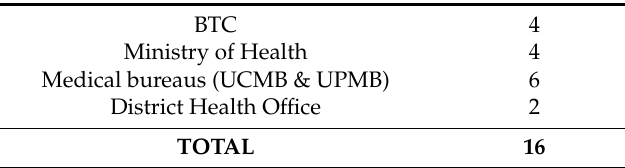
Table 3. Overview of key informants